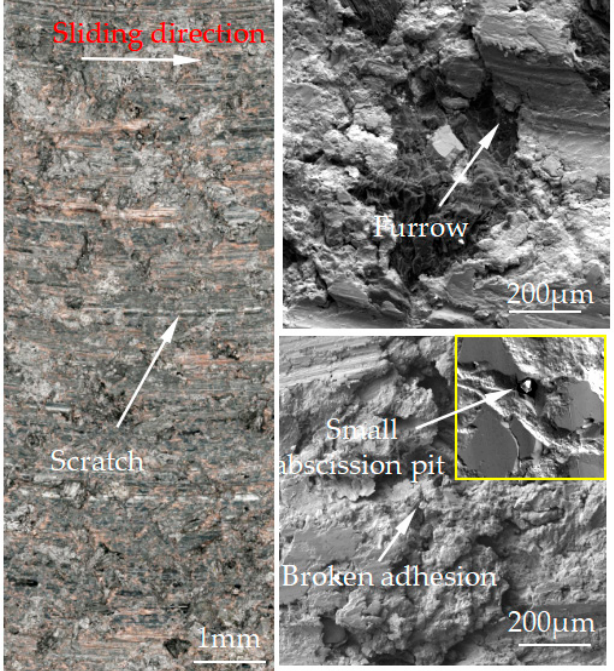
Figure 8. Surface morphology of the pad material after intermittent braking at an ambient temperature of 0 °C.